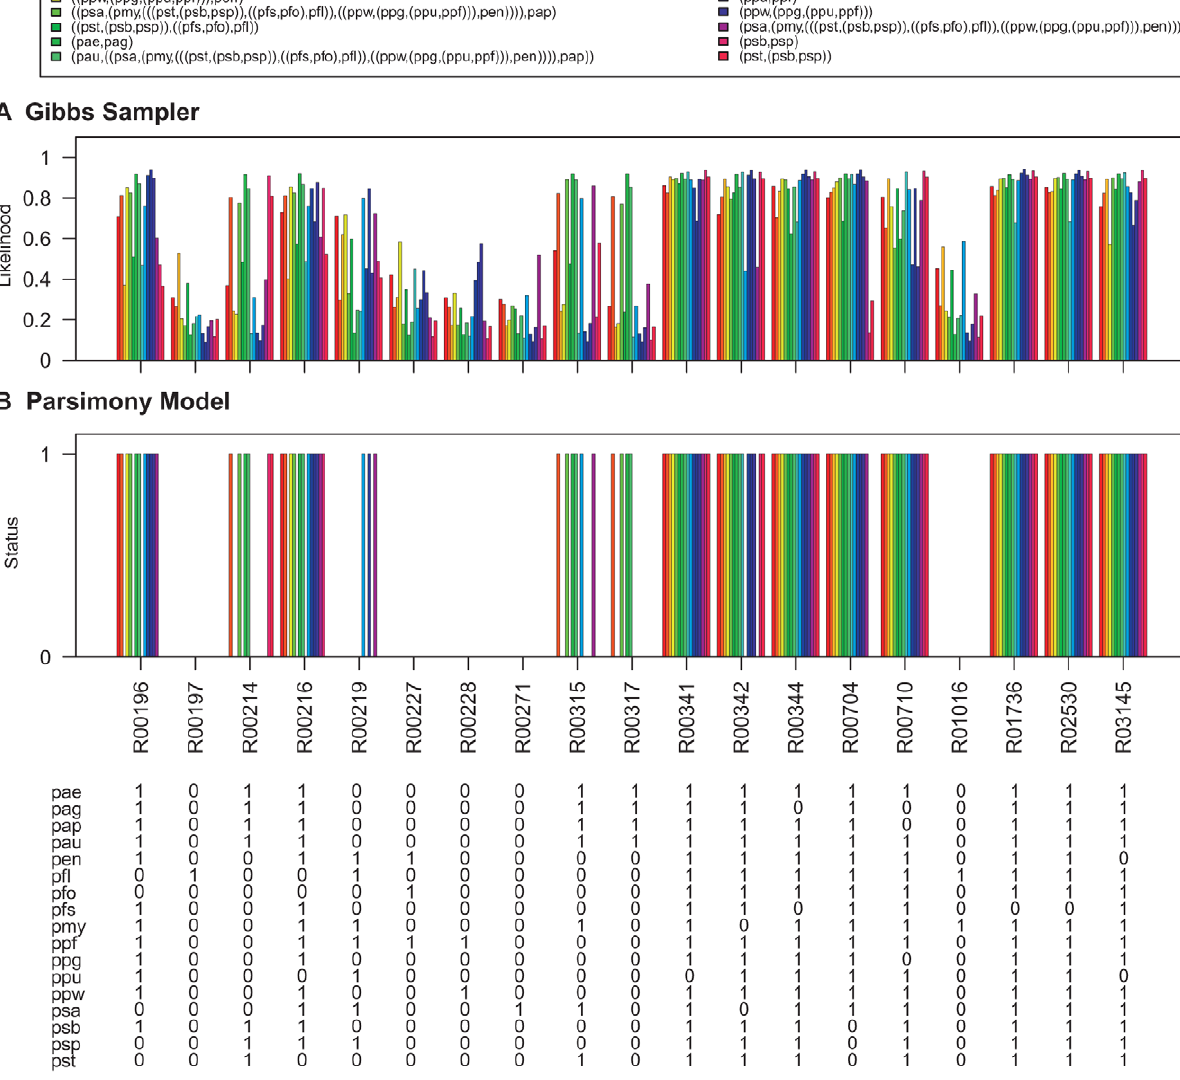
used for generating the tree and their evolutionary distances.